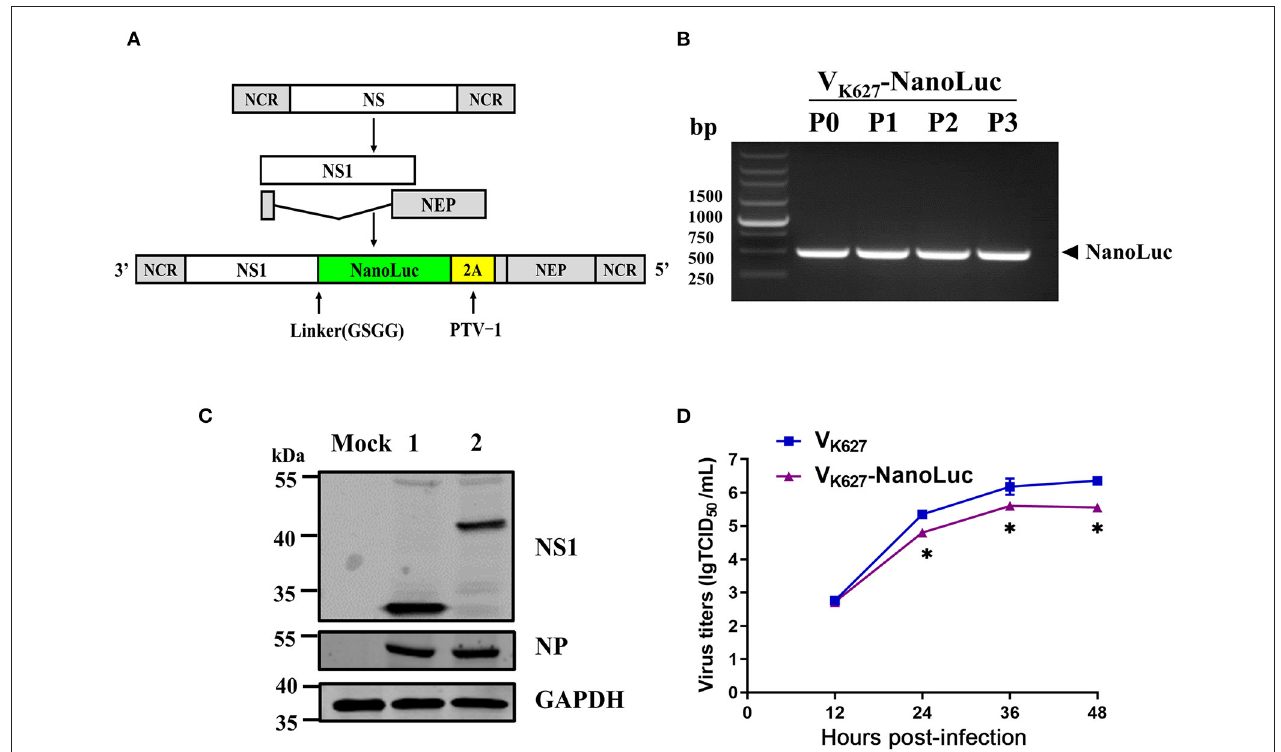
FIGURE 1 | Generation of an influenza reporter virus carrying a NanoLuc gene. (A) Schematic diagram of NS segments of V K627 virus and V K627 -NanoLuc virus. NS1 coding sequence (white) was fused to NanoLuc coding sequence (green) via a GSGG linker, followed by a sequence of 2A peptide from porcine teschovirus